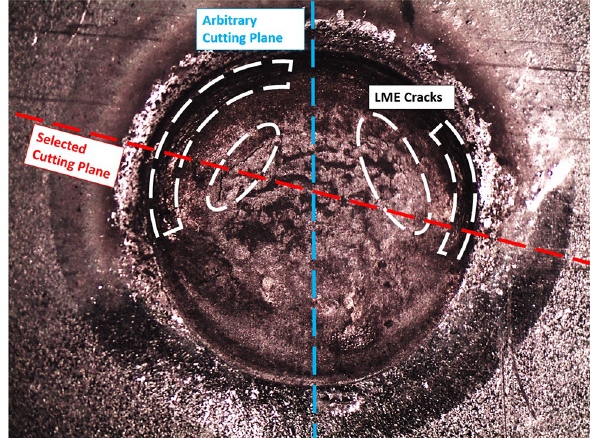
Fig. 1 Cutting planes using the selected cutting plane and arbitrary cutting plane methods